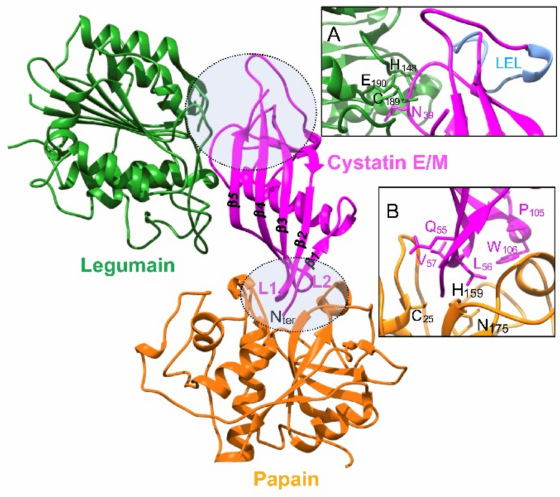
Figure 1. Structural schema representing cystatin M/E complexed with papain and human legu- main. A model of cystatin M/E complexed with papain was performed using the protein structure homology-modelling Swiss-Model server (https://swissmodel.expasy.org/interactive) (accessed date: 31 January 2021). The structure of tarocystatin-papain (PDB: 3IMA.1) was used as a template (79.19% sequence identity of tarocystatin with cystatin M/E). The modeled cystatin M/E structure was then superimposed with the crystal structure of legumain in complex with cystatin M/E (PDB: 4N6N) [36]. Inhibitory sites of cystatin M/E are indicated by a circle. Inset A: zoom-in view of the legumain-interacting inhibitory loops: reactive center loop (RCL, including residue N39) and exosite loop (LEL). Inset B: zoom-in view of the inhibitory segments L1 (Q55LVAG59) and L2 (P105W106) of cystatin M/E with the active site of papain (catalytic triad: C25, H159, and D175). Key residues are shown in stick representation. Cystatin C numbering is used for cystatin